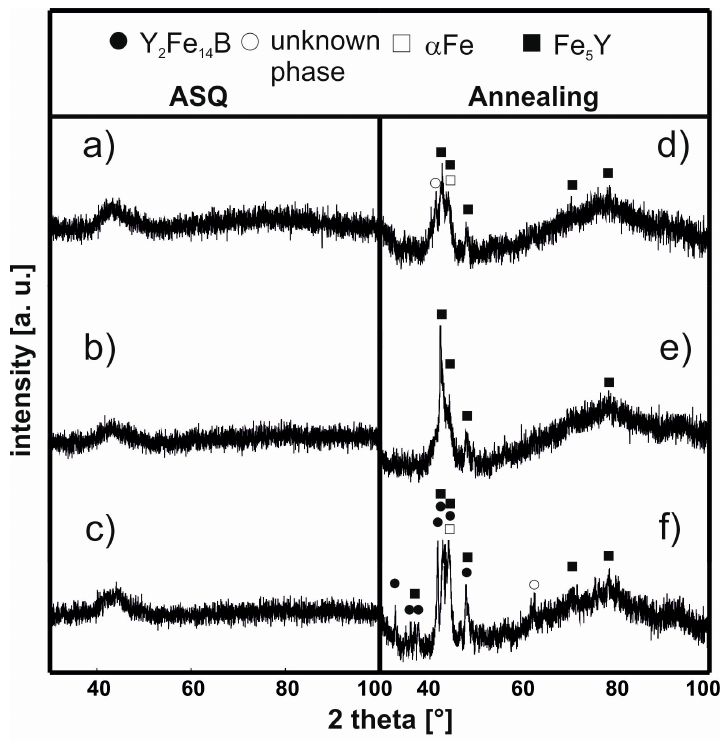
Figure 4. X-ray diffraction patterns for the alloys in the as-cast state ( a – c ) and following the thermal treatment at 940 K for 10 min ( d – f ) produced using the suction-casting method: Fe 61 Co 10 W 1 Y 8 B 20 , ( a,d ), Fe 62 Co 9 W 1 Y 8 B 20 ,( b,e ) Fe 63 Co 8 W 1 Y 8 B 20 ( c,f ).